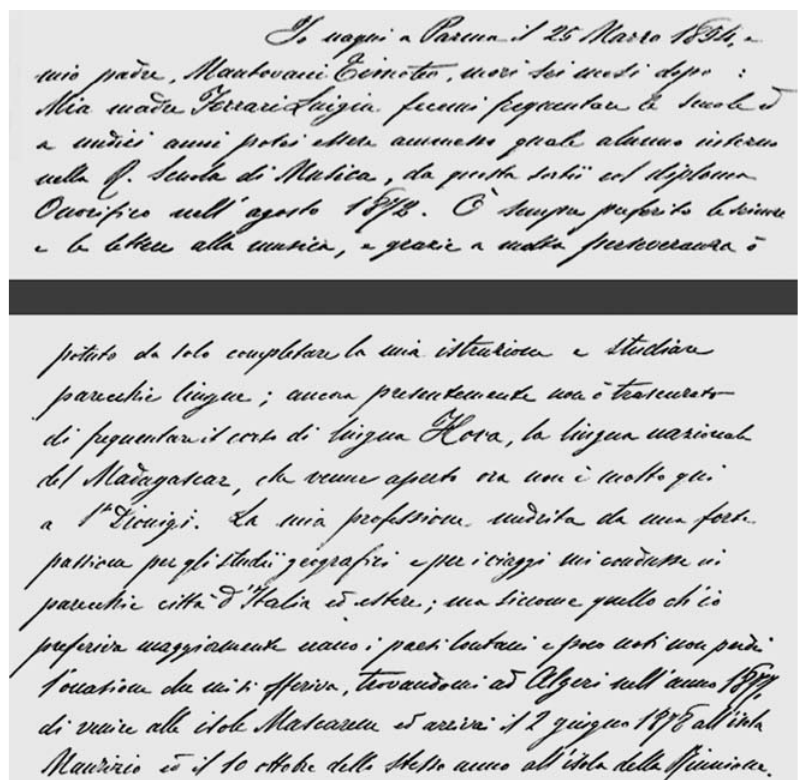
Fig. 3. The autobiographical letter of Mantovani which was sent to the Ministry of Foreign Affairs in the occa- sion of his request for the appointment as Consul of Italy at La Réunion Island ( Archives of the Ministry of Fo- reign Affairs, Rome). This letter of Mantovani says: « I was born in Parma on March 25, 1854. My father, Tim- oteo, died six months later. My mother, Luigia Ferrari, directed me to the studies, and at the age of 11 I was ac- cepted as boarder in the Royal School of Music, where I was conferred with the Honorific Degree, in August 1872. Having always preferred the exact sciences and literature to music, it was with great perseverance that I succeeded in completing myself my studies and learning several languages […]